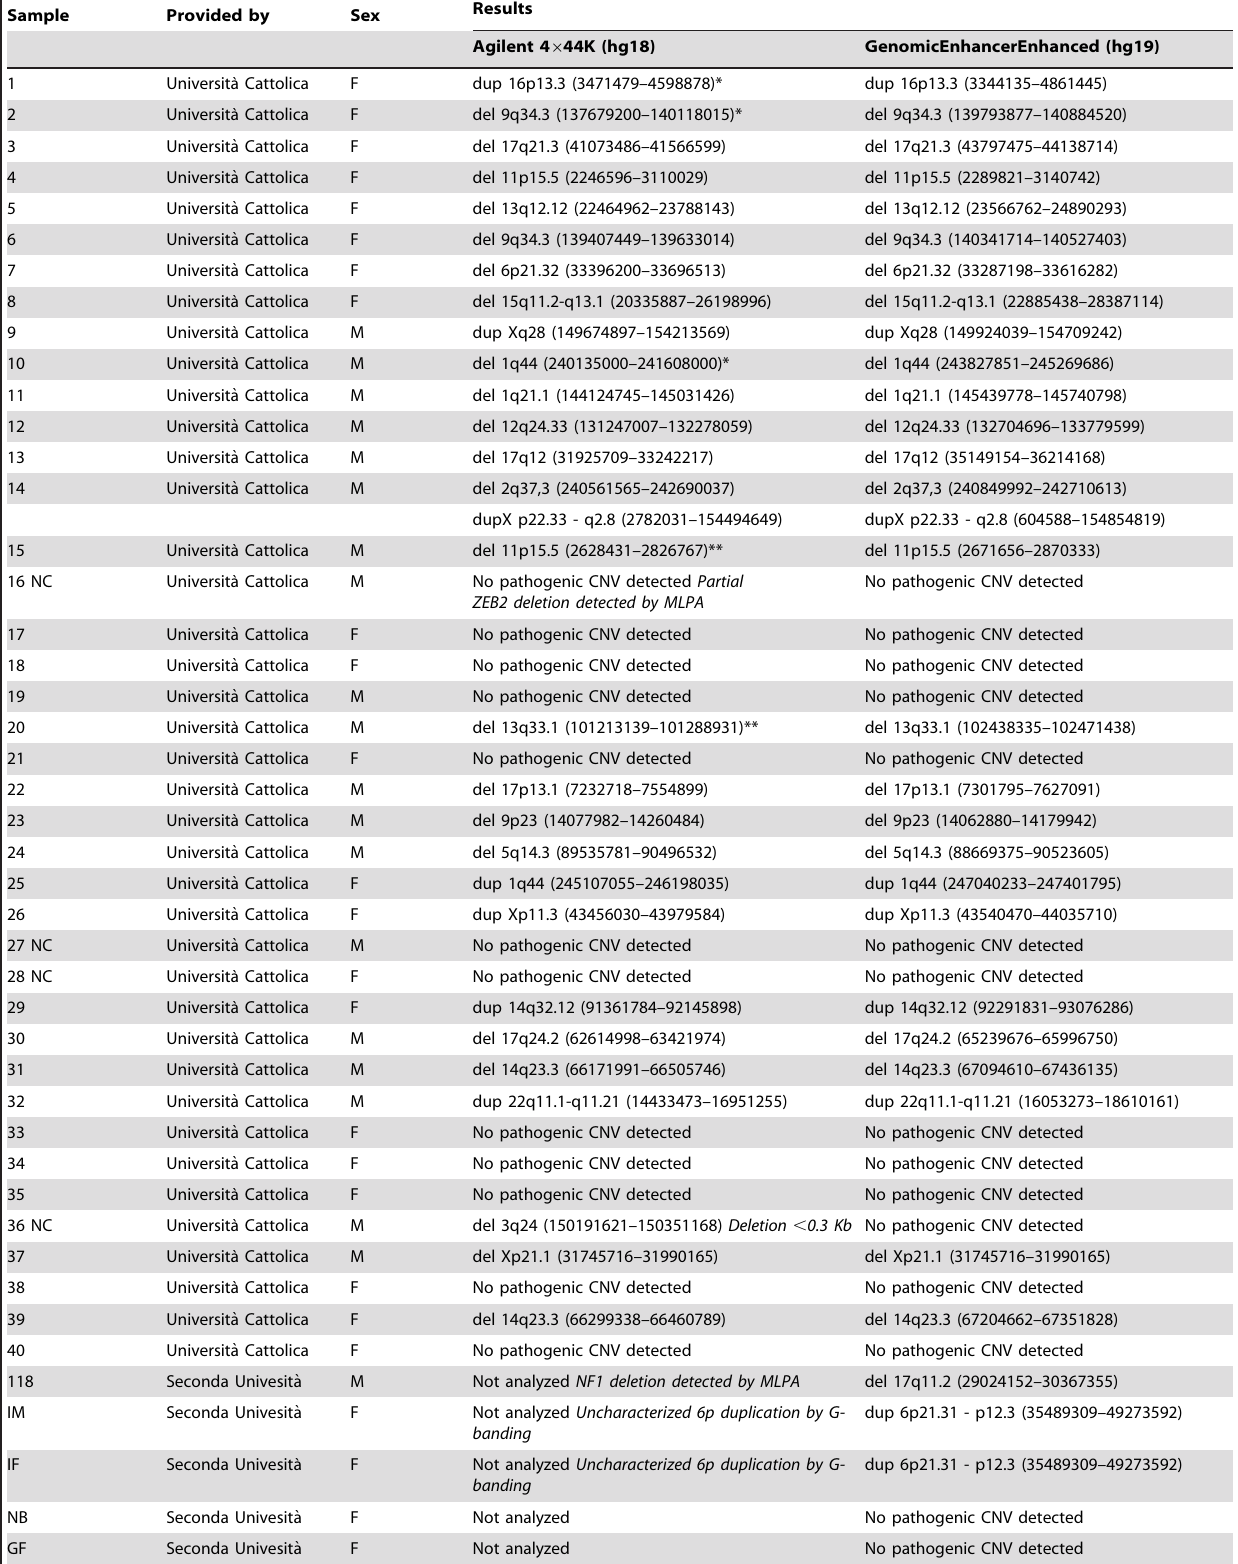
Table 3. Pathogenic CNV detected.